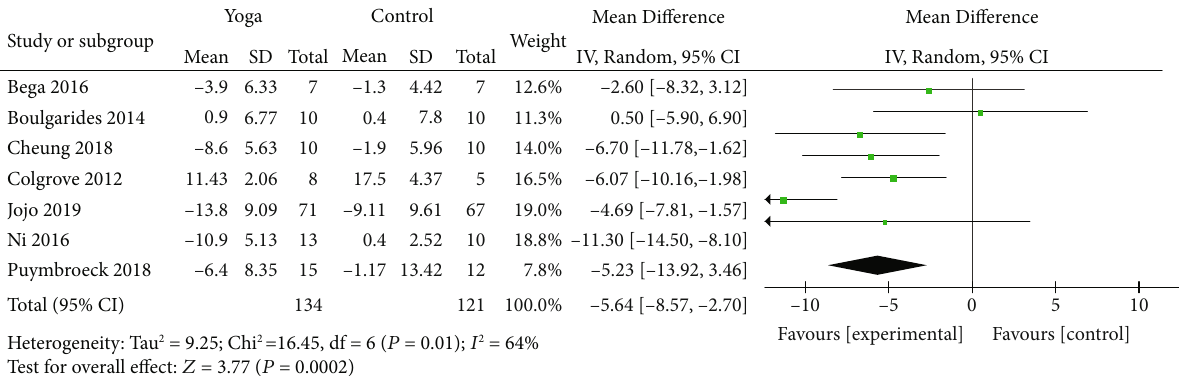
Figure 3: Forest plot from the meta-analysis of yoga on motor status.